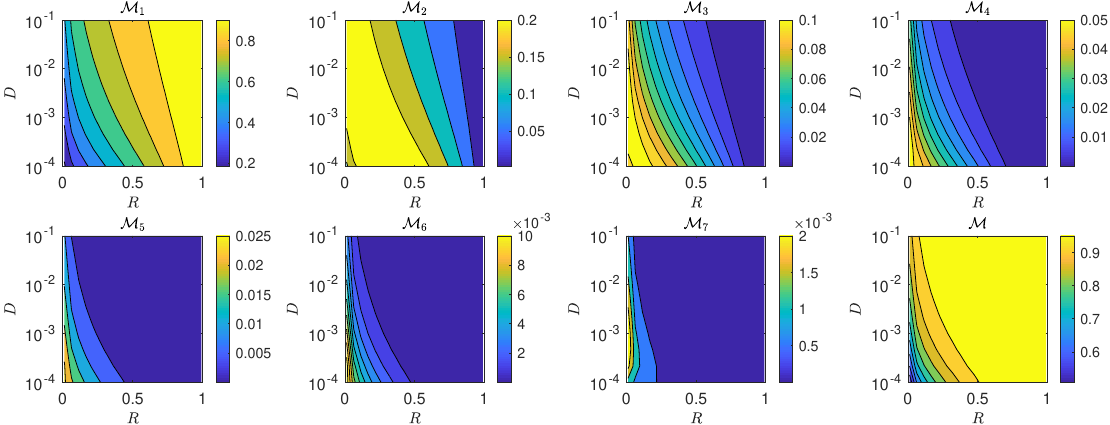
Figure 7. Night-by-night and total mating probabilities for the increase calling strategy. Note the different likelihood scales for each panel. On the first night, the mating likelihood M 1 is highest for high-quality moths (large { R , D } ), and lower for intermediate and low-quality moths (medium and low { R , D } ). The latter reaches the female with relatively large likelihoods on the second and successive nights, as can be seen for M (cid:96) with (cid:96) > 1. The last panel displays the total capture and mating likelihood at the end of the one-week mating period.